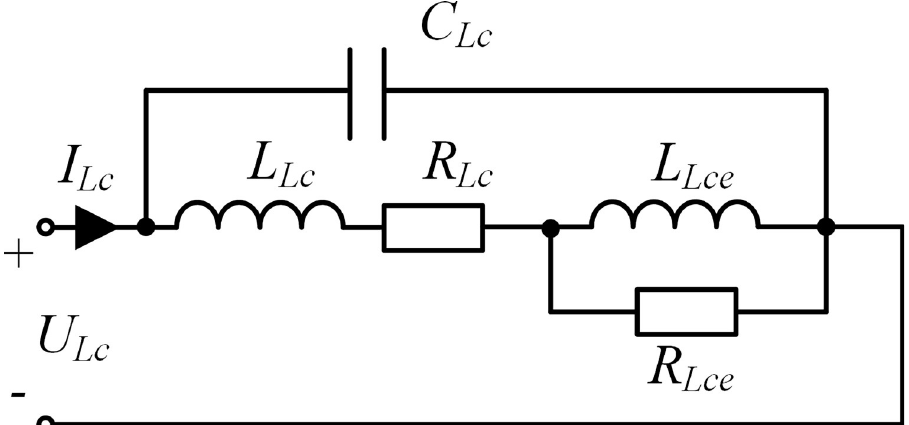
Fig 3. Element parameter calculation for the compensation